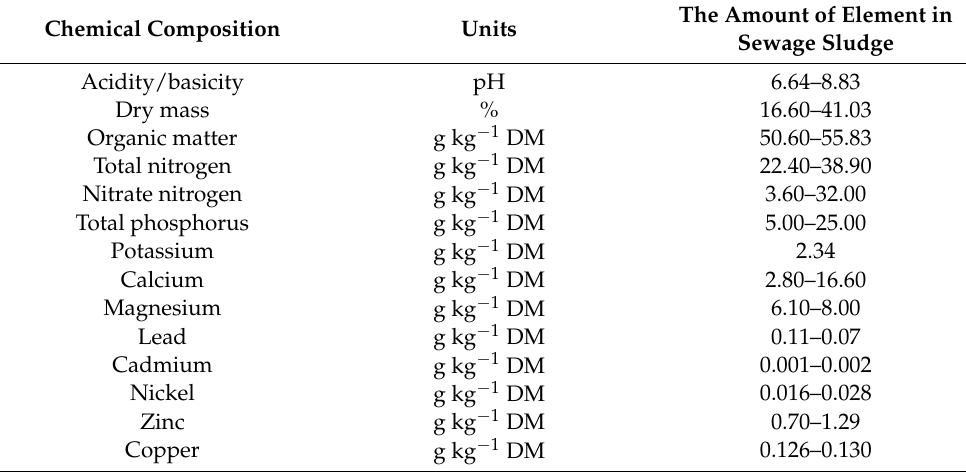
Table 1. Examples of the chemical composition of sewage sludge